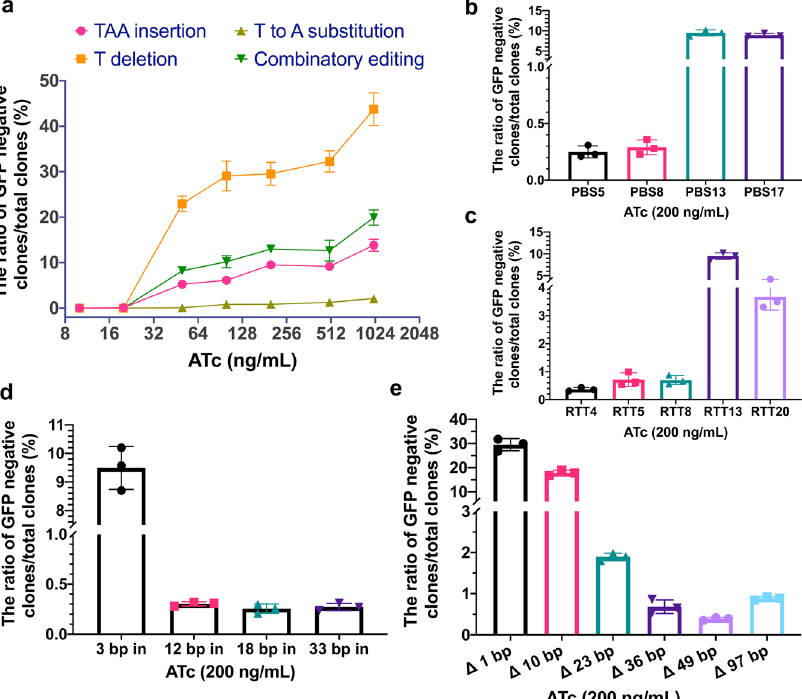
Fig. 3 Characteristics of CRISPR-Prime Editing system for DNA engineering in E. coli . The editing ef fi ciency was de fi ned as ratio of white clones (GFP- negative)/ total clones on a screening plate. a . Eight different concentrations of ATc, ranging from 0 to 1000 ng/mL (0, 10, 20, 50, 100, 200, 500, and 1000) were used to evaluate the induction of CRISPR-Prime Editing system on four DNA engineering events of 3 bp insertion, 1 bp deletion, 1 bp substitution, and the combinatorial editing. b The evaluation of PBS length. c The evaluation of RTT scaffold length. d The capacity of DNA fragment insertion with different sizes. e The capacity of DNA fragment deletion with different sizes. Mean ± s.d. of three biological replicates are shown. 200 ng/mL of ATc was used for b – e